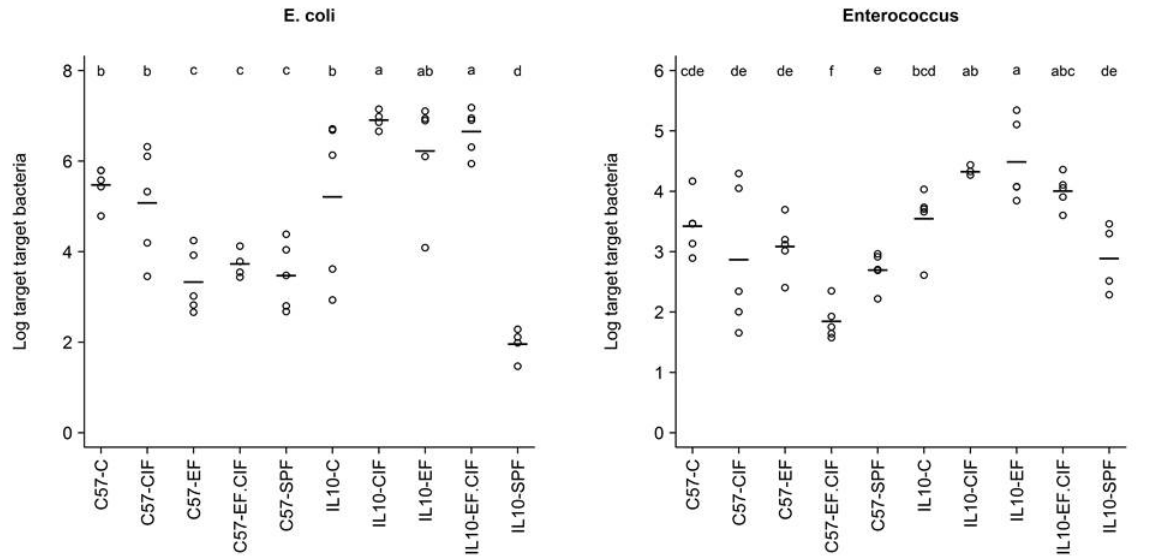
Figure 5. qPCR quantification of the total number of bacterial cells in the caecum of Il10 -/- and C57 mice housed in either specific pathogen free (SPF) conditions or maintained under conventional conditions (C) and also receiving either an oral bacterial inoculation of 12 E. faecalis and E. faecium strains (EF), complex intestinal flora collected from healthy control mice (CIF), or a 50:50 mixture of the two (EF.CIF). The horizontal lines represent the mean bacterial cell numbers of the individual mice; cell numbers of bacteria that differ significantly between groups ( p < 0.05), when comparing between mice from the same genotype in different treatment groups are labelled with different letters. Mouse genotype/treatment groups are represented along the x -axis.